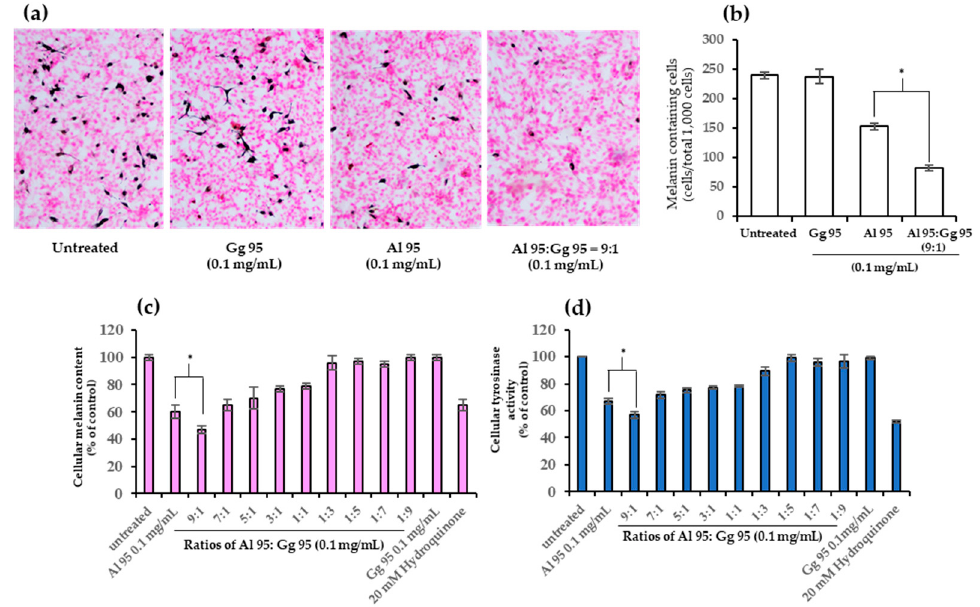
Figure 5. Effect of combined A. lakoocha and G. glabra on cellular melanin content and tyrosinase activity. ( a ) Melanin pigments (black) in B16 cells (pink) observed under a light microscope (Magnification x100); ( b ) the number of melanin containing cells from a total of 1000 cells counted under a light microscope; ( c ) cellular melanin content; ( d ) cellular tyrosinase activity. Cells were treated with combinations of Al95 and Gg95 at a final concentration of 0.1 mg/mL in several ratios for 48 h. The data are means ± SD from three independent experiments. The superscript letters (*) indicate significant difference at p < 0.01.